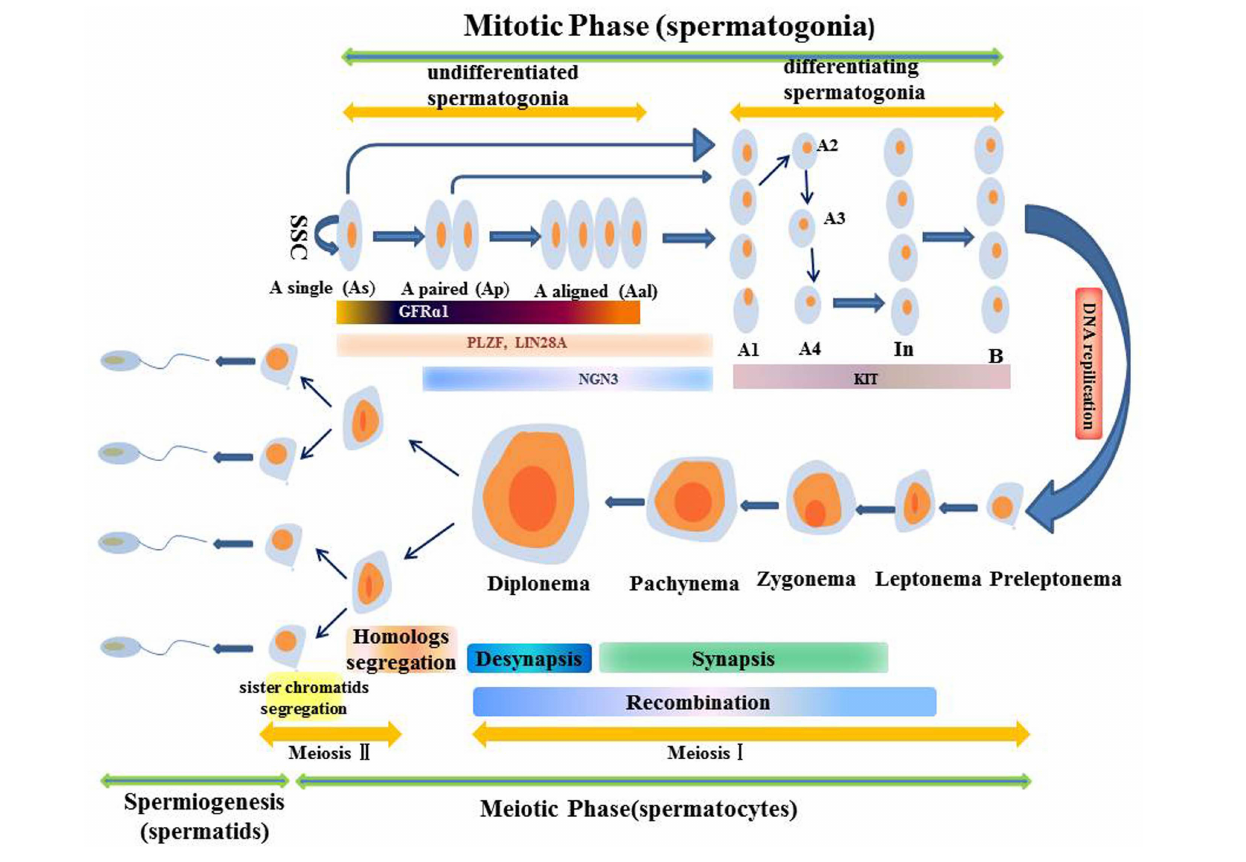
FIGURE 2 | Schematic illustration of the